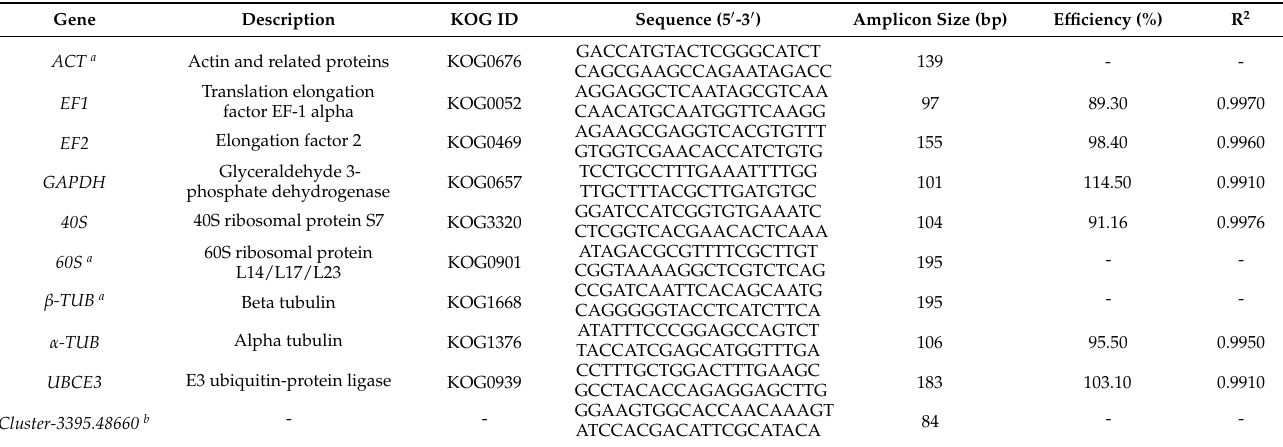
Table 1. Primers for real-time quantitative